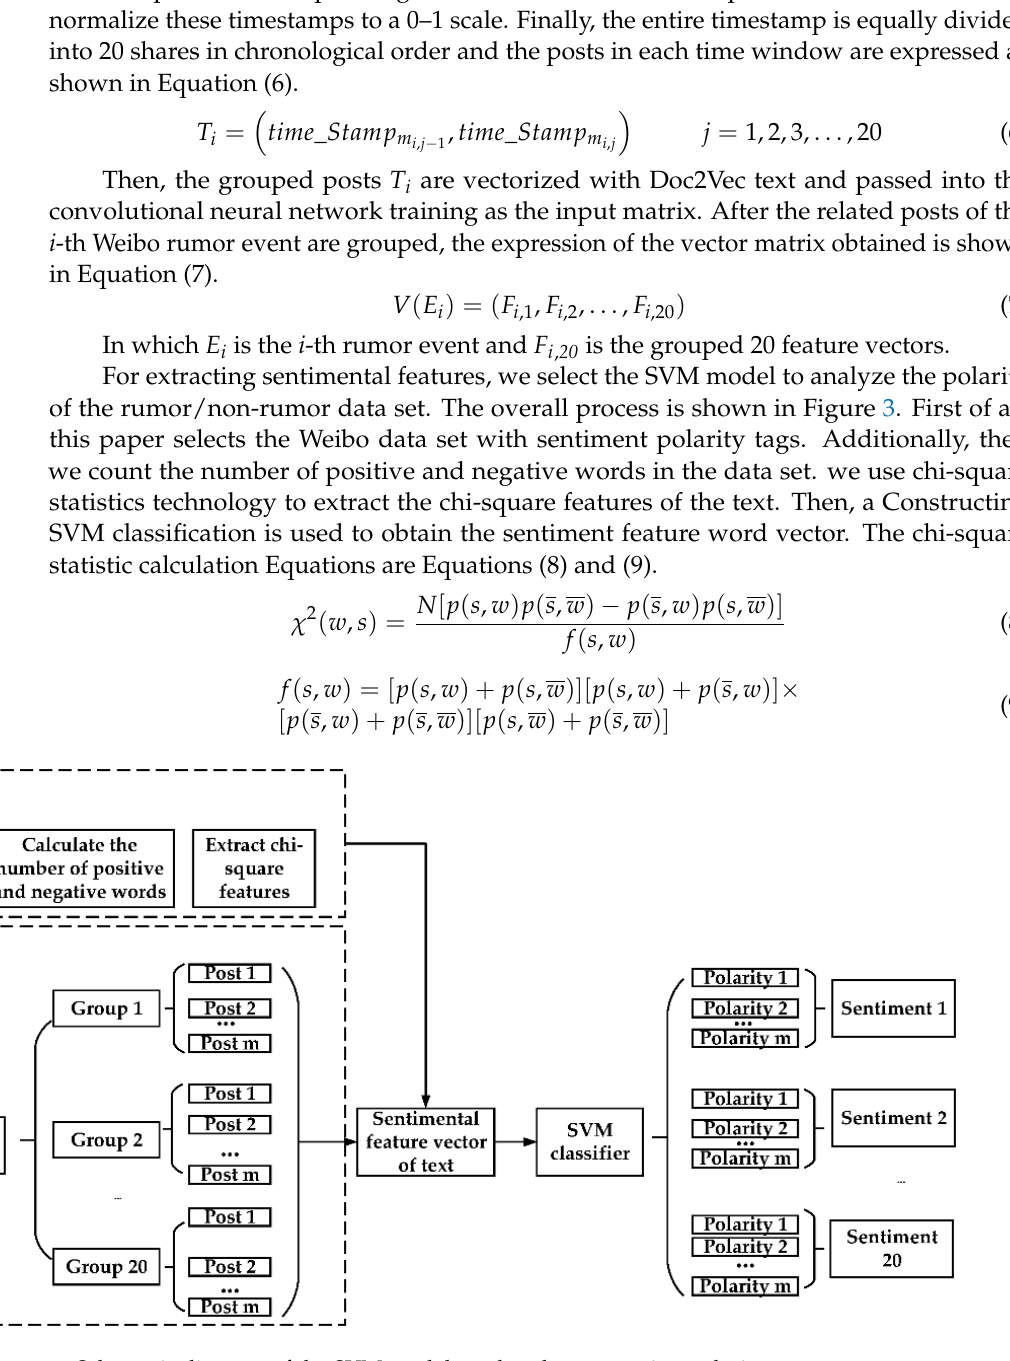
Figure 3. Schematic diagram of the SVM model used to detect emotion polarity.